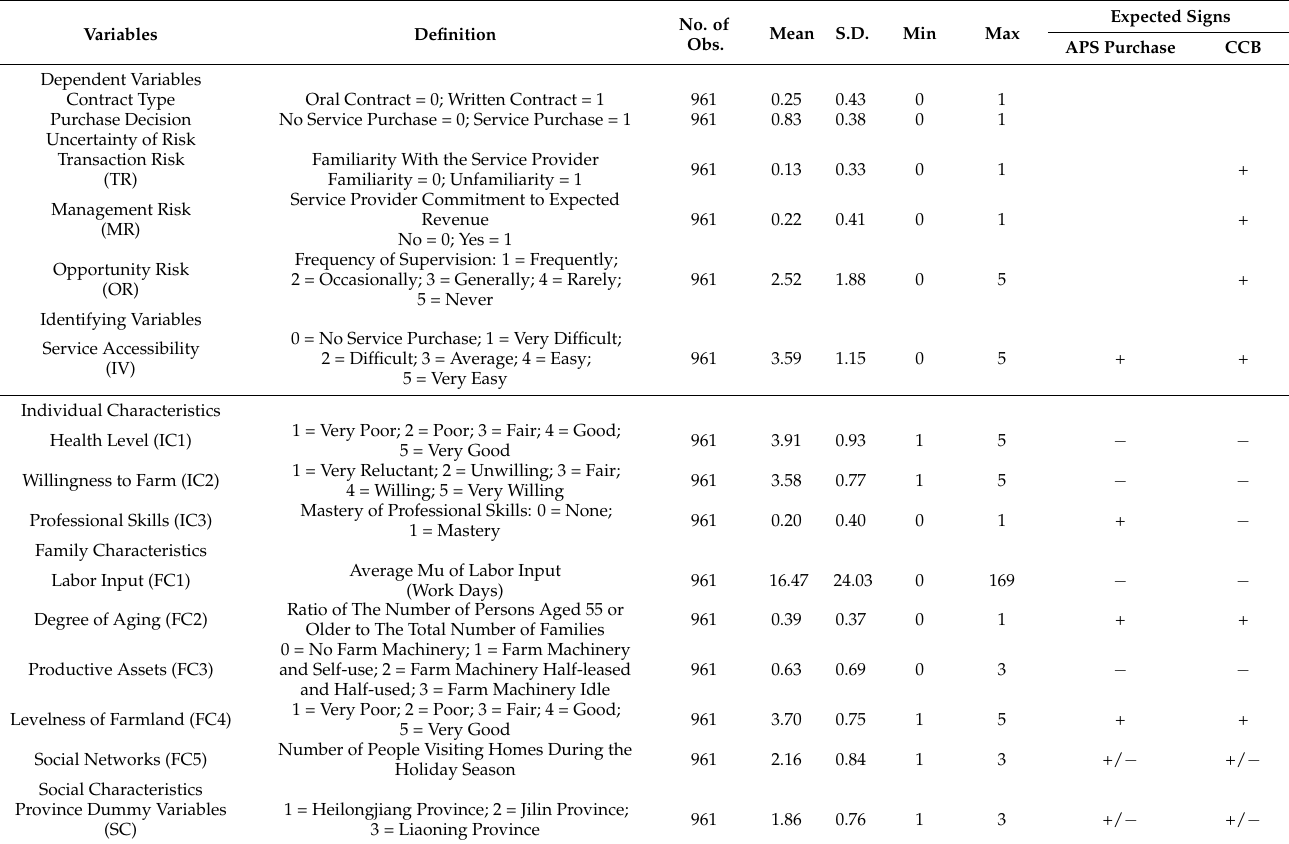
Table 2. Descriptive statistics of the